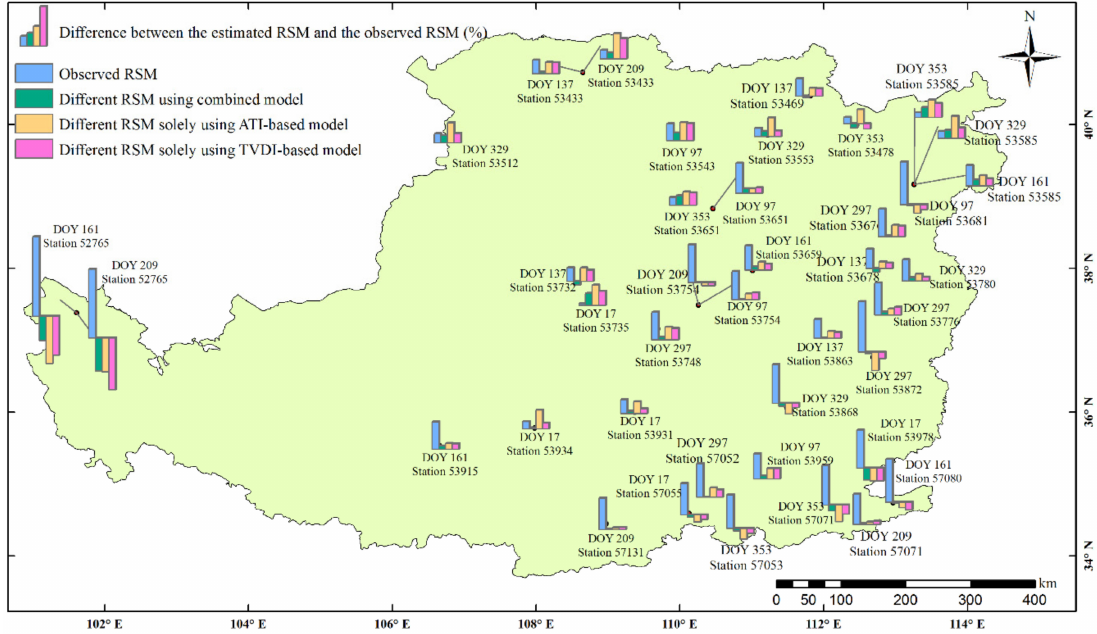
Figure 14. Comparison of di ff erences between the estimated RSM and the observed RSM using di ff erent models at some stations on DOYs 17, 353 (in winter), 97, 137 (spring), 161, 209 (summer), 297, and 329